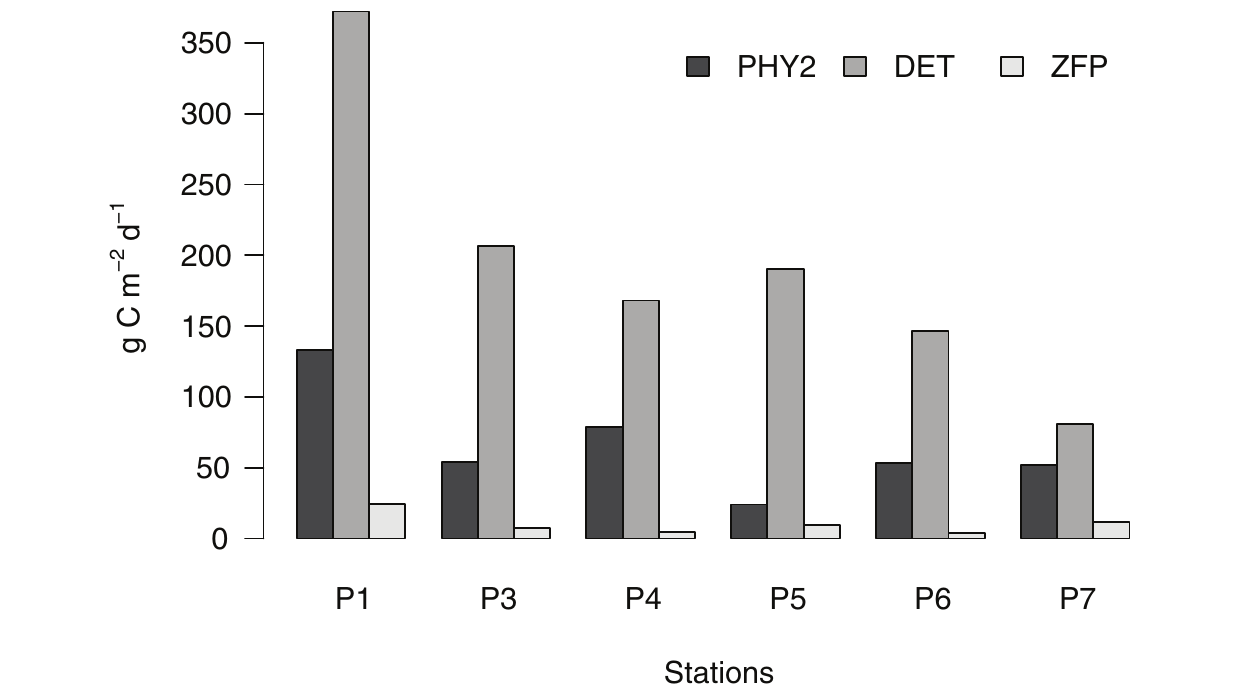
FIGURE 6 | Partitioning of the vertical flux of organic particles. ZFP denoted direct vertical flux of fecal pellet carbon combined from both mesozooplankton size classes.